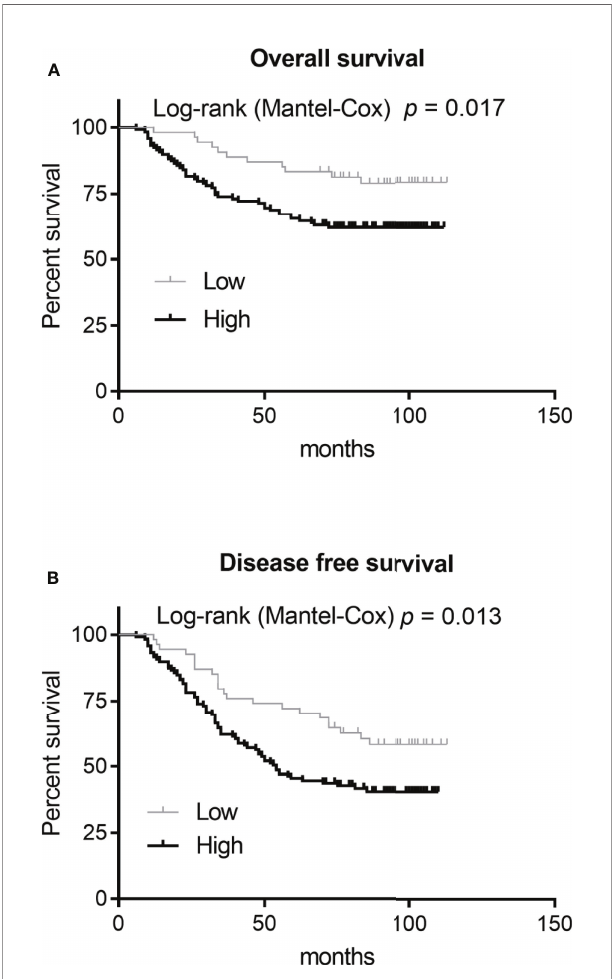
FIGURE 1 | Correlation analysis between RNASE2 protein levels and patient prognosis. Based on the RNASE2 protein levels on the glioma tissue microarray, 173 patients with glioma were grouped into low (score <2) and high (score ≥ 2) expression groups. A Log-rank (Mantel-Cox) test was used to assess the correlation between RNASE2 levels and overall survival, or RNASE2 levels and disease-free